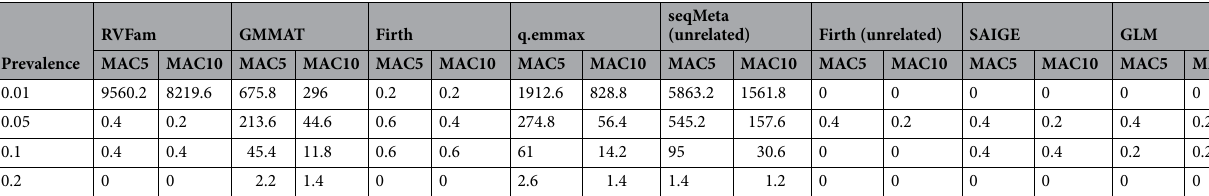
Table 2. Estimated type I error rates (Type I error rate was computed by total number of SNPs that passed genome-wide significance threshold in 100 replicates divided by total SNPs in 100 replicates, which has been calibrated by dividing the significance threshold. A value greater than 1 indicates inflation) after applying MAC filters of 5 and 10 in single variant tests (SVT) of the first simulation study. Genome-wide significance level: SVT = 2.027E−7. Methods with “unrelated” are those applied to unrelated samples, all other approaches were applied to related samples.